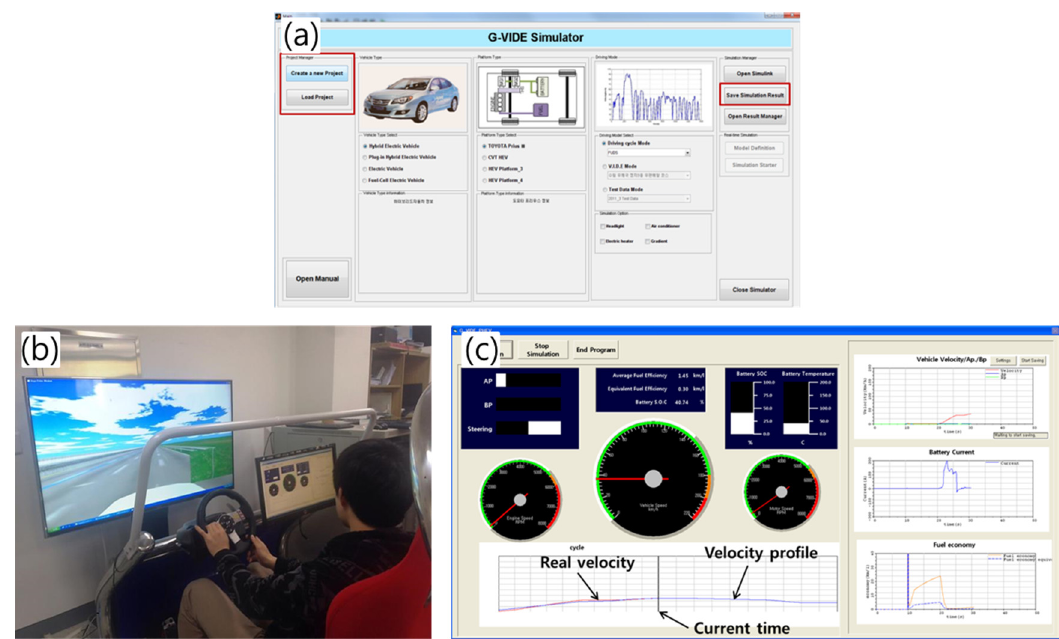
Figure 5. ( a ) The virtual integrated driving environment (VIDE) library; ( b ) the VIDE hardware and driver; ( c ) display screen.